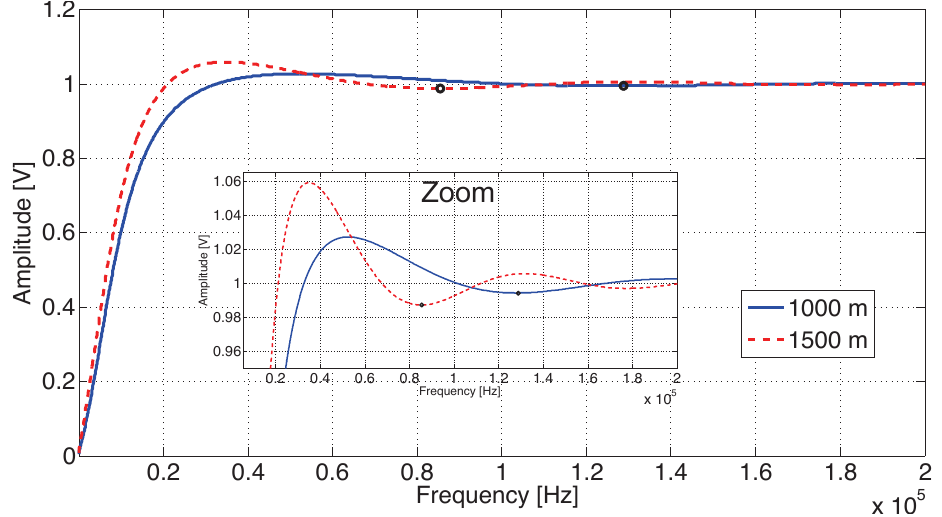
Figure 8. Behavior of the observed amplitude B with respect to the frequency for a lossy transmission line, as in (20). Short circuit at 1000 m and 1500 m. The velocity of propagation v is constant and considered as 90% the velocity of light and the frequency bandwidth is 100 Hz up to 200 kHz. The frequency was varied in steps of 100 Hz. The dots marked with a circle correspond to the identification of the